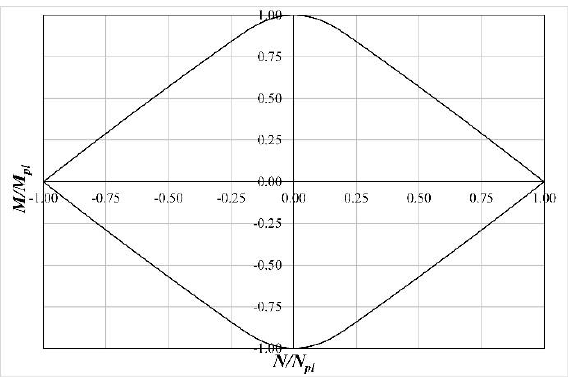
Figure 7. Dimensionless yield domain for beam with H cross-section profile.